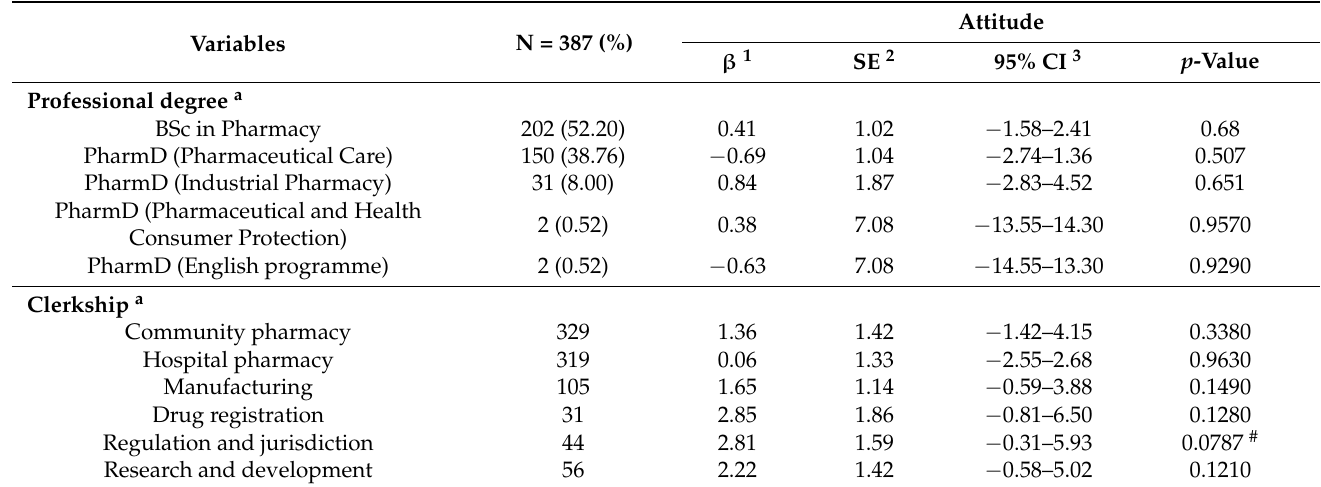
Table 6. Bivariate analysis of Attitude with professional background factors.